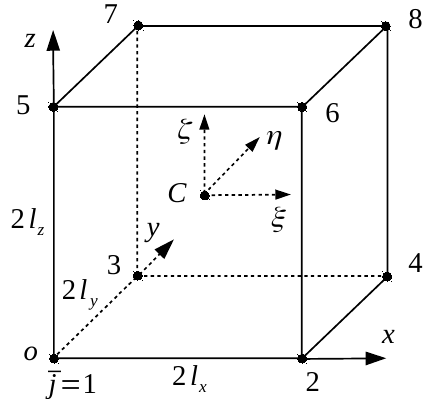
Figure 2. Rectangular cuboid element with lengths 2 l x , 2 l y , and 2 l z . C is the center point of the cell, and j = 1, . . . ,8 is the local index of a grid